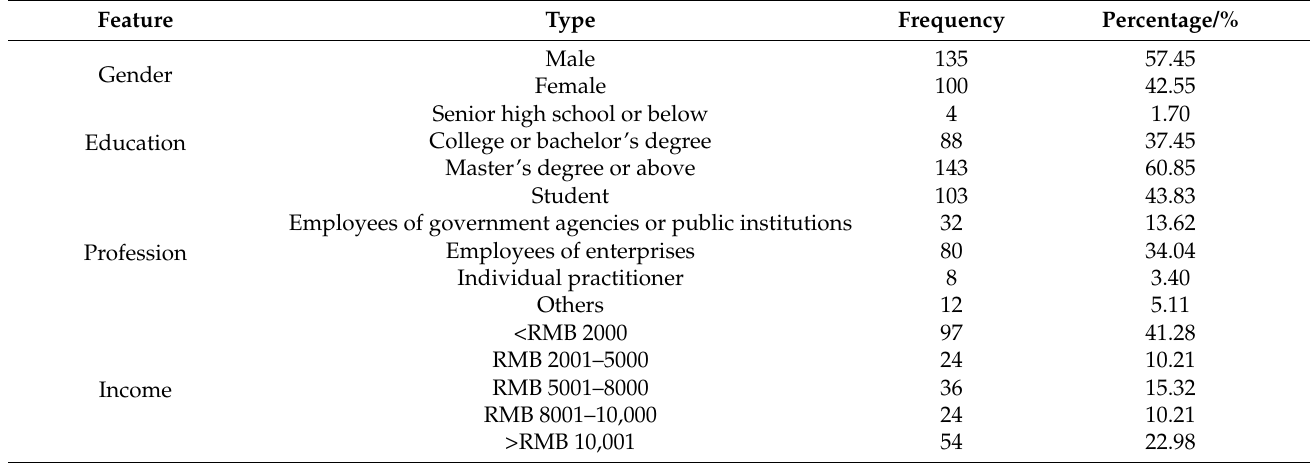
Table 2. Demographic characteristics of the